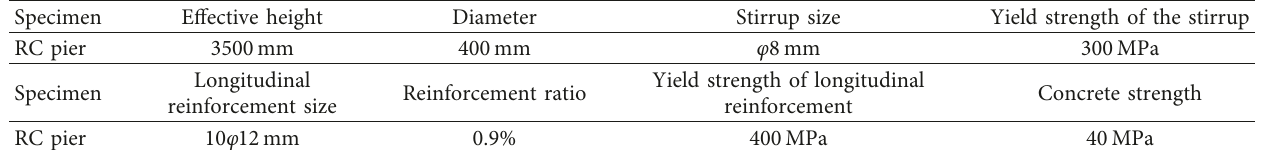
Figure 2: RC pier experiment: (a) test specimen; (b) explosive Table 2: Essential design parameters of the RC pier.